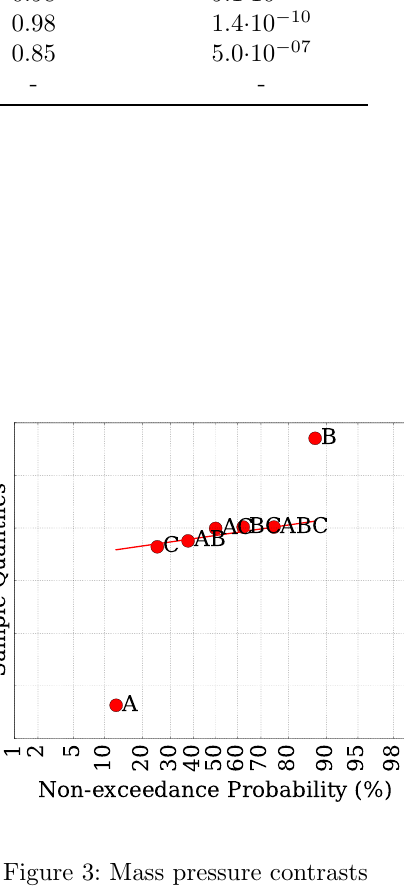
Figure 3: Mass pressure